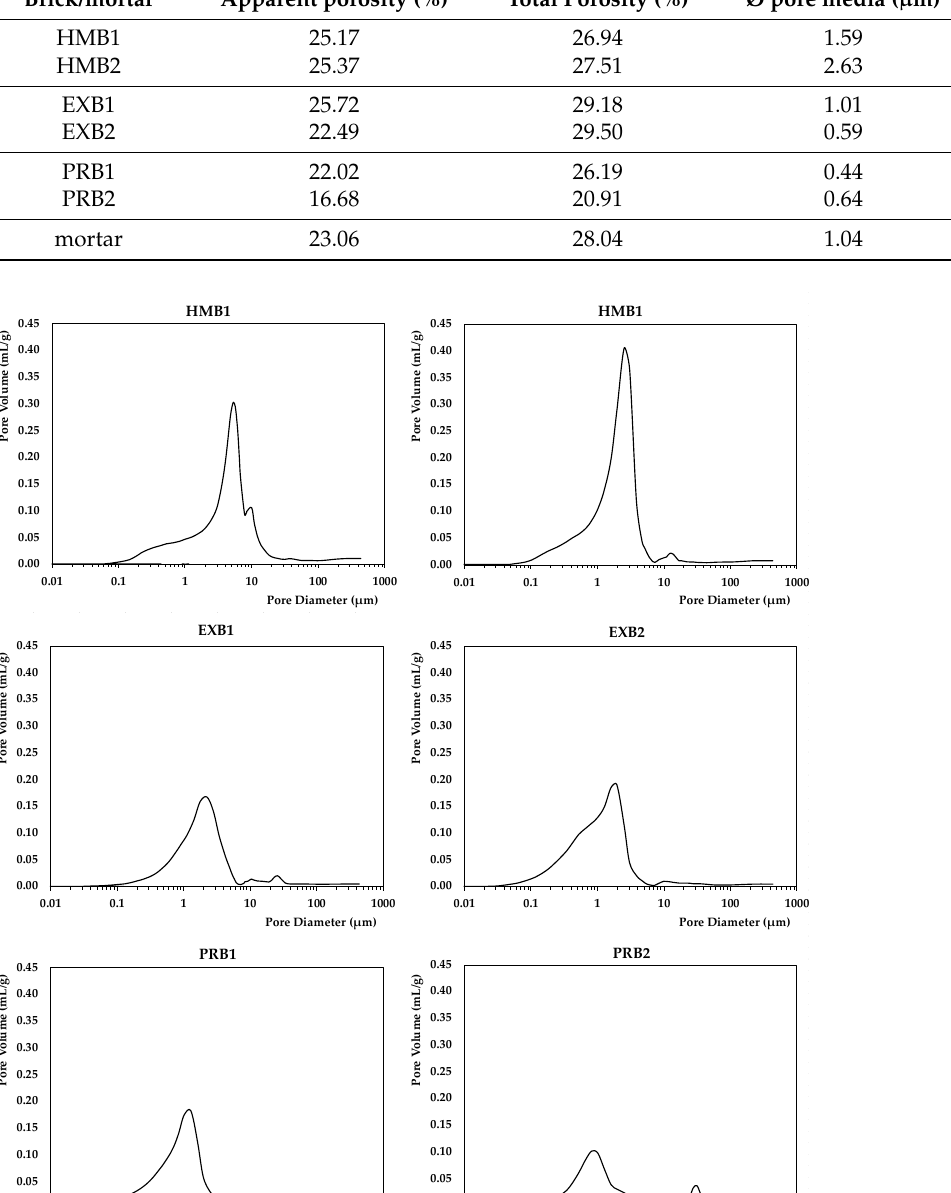
Table 4. Test results of test samples.